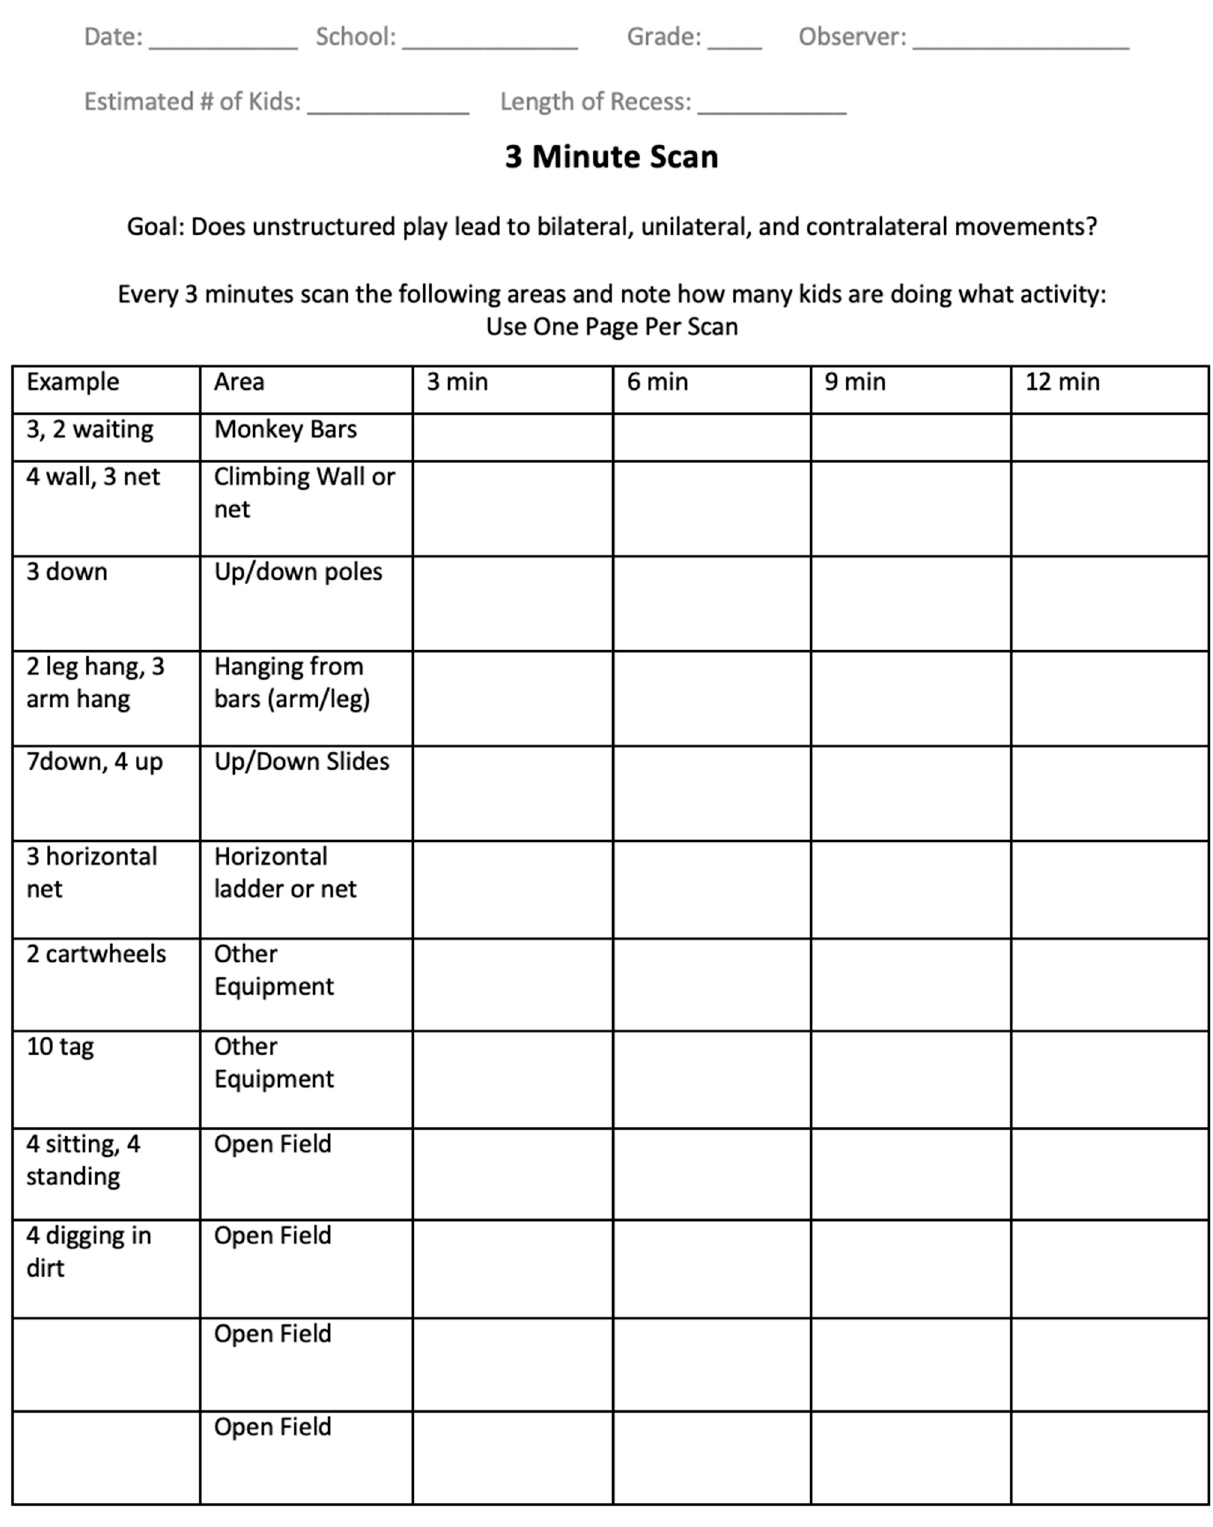
Figure 2. Second Movement Pa tt ern Observation